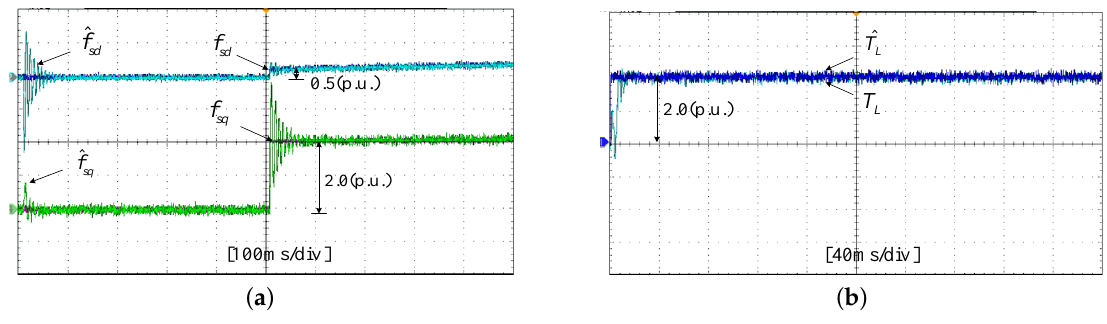
Figure 26. Experimental results of incipient sensor faults, unknown load and their estimated values. ( a ) Sensor faults f d , f q and their estimated values ˆ f d , ˆ f q ; ( b ) unknown load T L and its estimated value ˆ T L